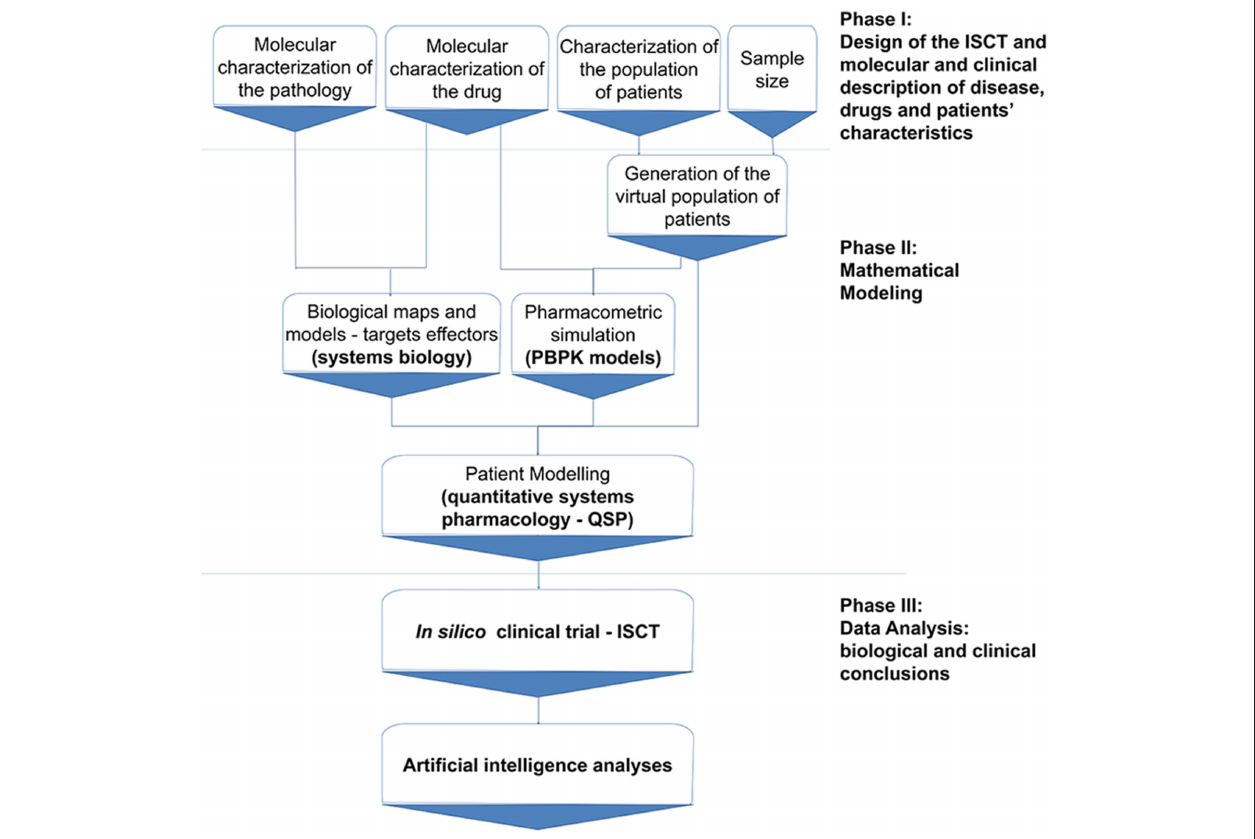
FIGURE 1 | In silico clinical trial protocol overview. The protocol is divided into three main stages: Phase I, including trial design and information compilation; Phase II, comprising mathematical modeling; and Phase III, consisting of data analysis according to the trial design. ISCT, in silico clinical trial; PBPK, Physiologically based pharmacokinetic; QSP, Quantitative systems